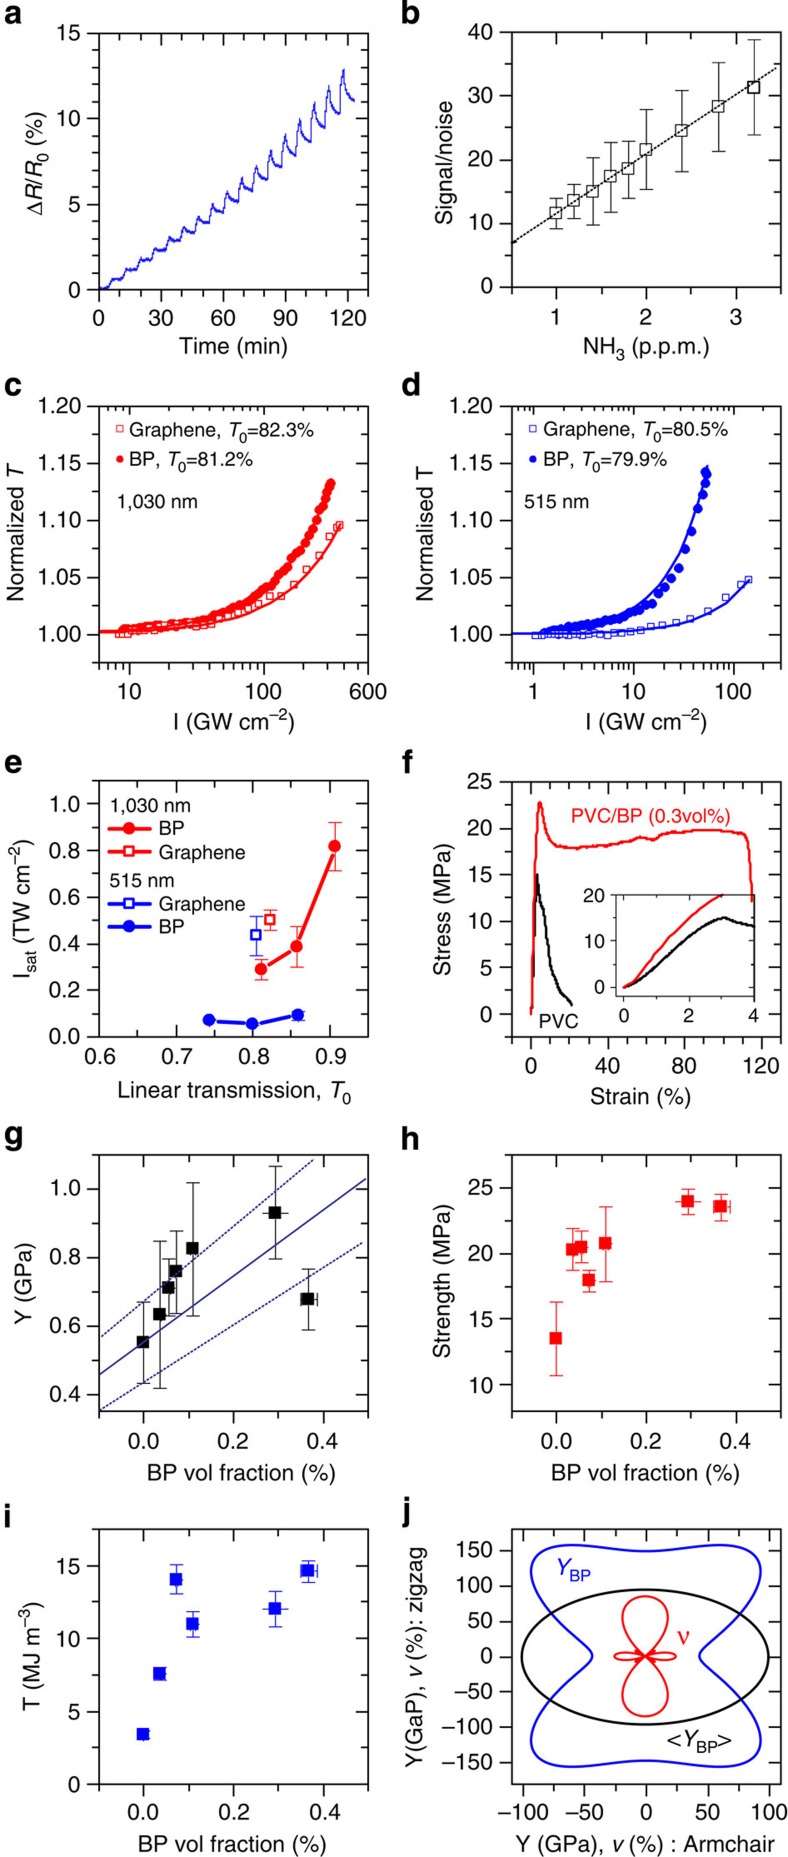
Applications of liquid-exfoliated FL-BP.(a,b) Sensing of NH3 gas using std-BP films. (a) Sensor response plot shows percentile resistance change versus time of the FL-BP films with a bias voltage of 1 V at room temperature, on consequent NH3 exposures at various concentrations from 1 to 10 p.p.m. (b) Plot of signal-to-noise ratio as a function of NH3 concentration from 1 to 3 p.p.m. The error bar represents the s.d. of five devices and the linear line indicates the fitted line. (c–e) Saturable absorption of std-BP and graphene in CHP for fematosecond pulses excited at (c) 1,030 nm and (d) 515 nm. Linear transmission T0 is given in the legend. (e) Saturation intensity of FL-BP and graphene as a function of T0. (f) Representative stress–strain curves for PVC and PVC: FL-BP (0.3 vol%). Inset: low strain regime. (g–i) Young's modulus, including the theoretical constant-strain rule-of-mixtures modulus prediction (blue using the Voigt–Reuss–Hill planar-averaged nanosheet modulus, blue-dashed using its Voigt and Reuss bounds) (g), tensile strength (h) and tensile toughness (i) plotted as a function of FL-BP volume fraction. (j) Calculated orientation dependence of the in-plane two-dimensional Young's modulus (YBP, blue) and Poisson's ratio (ν, red), of black phosphorus, together with the Voigt–Reuss–Hill averaged in-plane modulus (<YBP>, black). Errors in b,e,g–i are statistical errors associated with the fits.